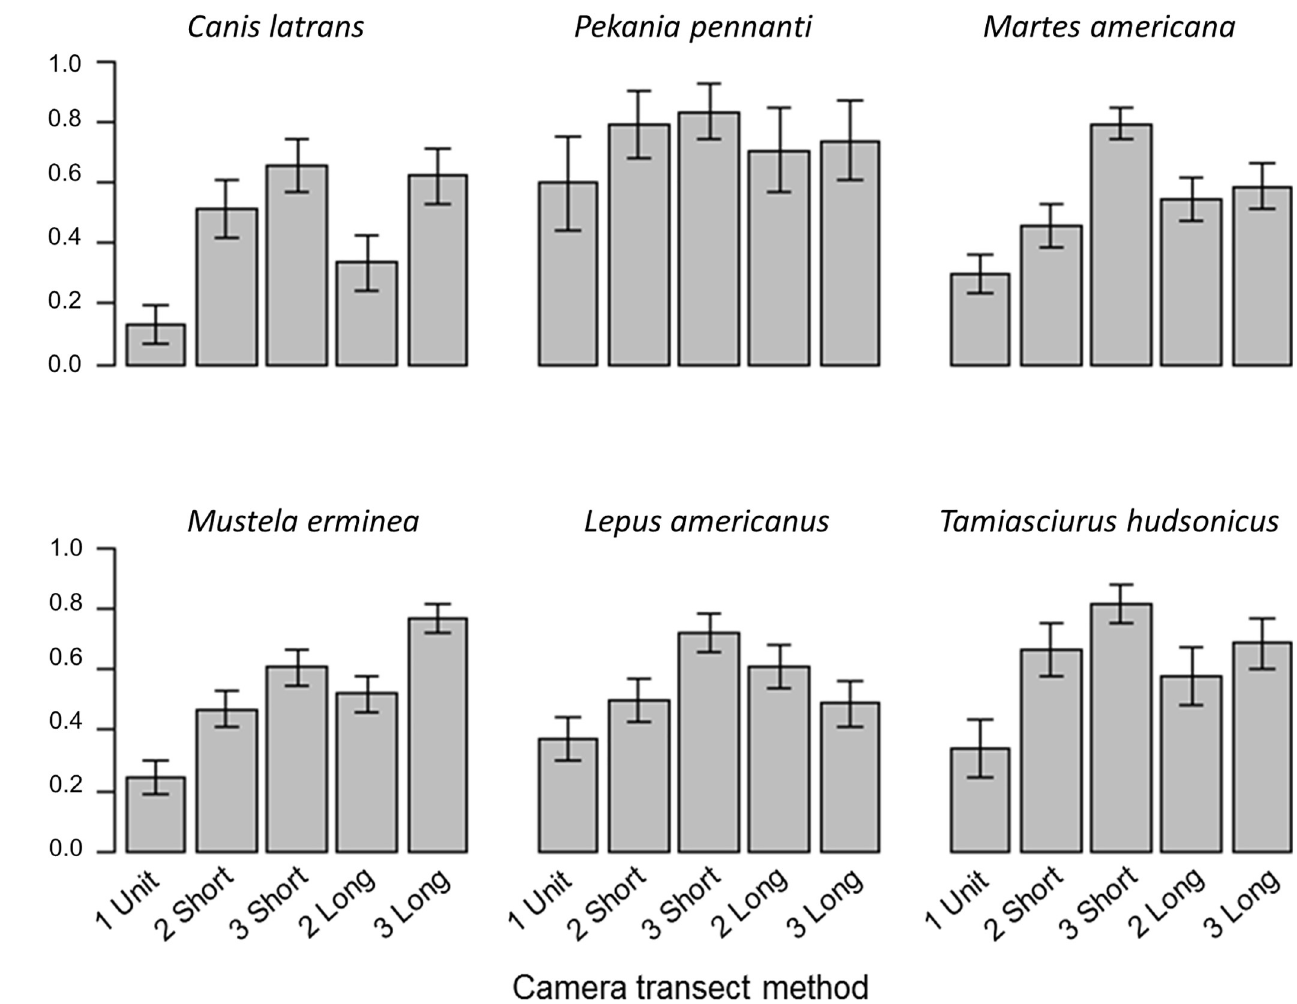
Fig 3. Model-averaged estimated detection probabilities and standard errors for camera trap surveys conducted in north and central Maine, USA, during winter 2017. The detection histories for six species were analyzed for five different potential survey methods of 1–3 camera units spaced short (100 m) or long (150 m). When derived from models including the study area parameter, results are shown for the Telos Road/Nahmakanta Public Reserve Lands, and when models included access type, results are displayed for plowed road access.